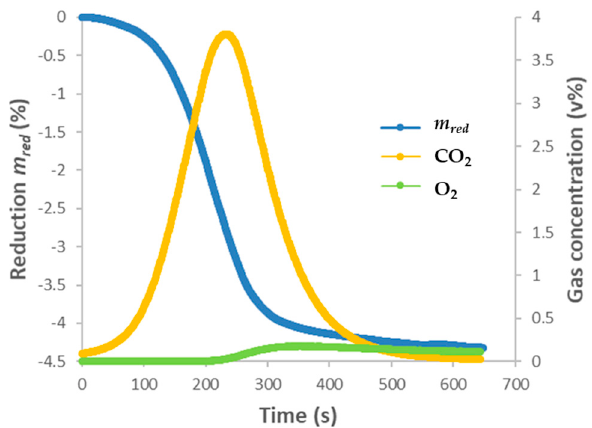
Figure 5. The reduction m red of Cu-OC with coal char, CO 2 and O 2 concentrations (QMS) versus time in Ar at 900 °C in a TGA-QMS.